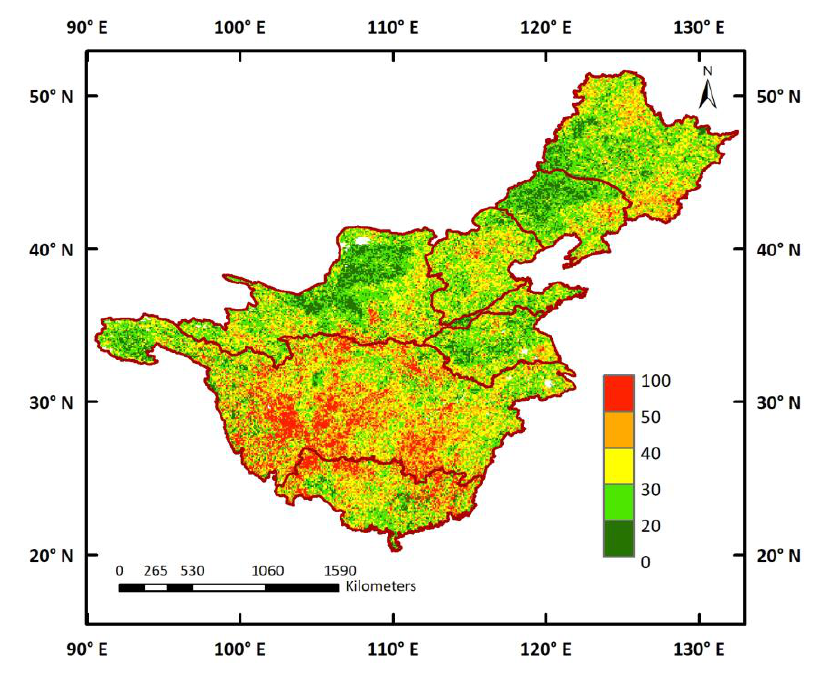
Figure 8. Spatial distributions of Vegetation Sensitivity Index (VSI) in seven major watersheds during 1982 – 2015.